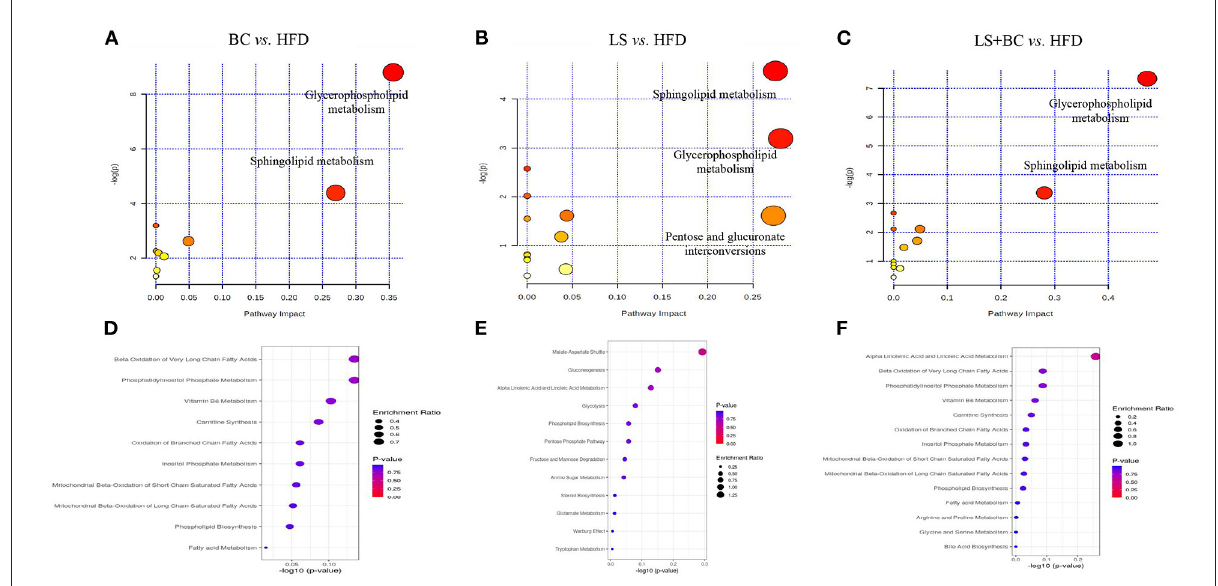
FIGURE7 Lipid metabolic pathway analysis based on significantly differential lipid species in serum. (A–C) All matched pathways are plotted according to p -value from pathway enrichment analysis and pathway impact score from pathway topology analysis. The color and size of each circle represented the p -value and the pathway impact factor, respectively. (D–F) Over Representation Analysis (ORA) is performed and implemented using the hypergeometric test to evaluate whether a particular metabolite set is represented more than expected by chance within the lipid metabolite. One-tailed p -values are provided after adjusting for multiple testing. Enrichment ratio is computed by hits / expected. The color and size of each circle represented the p -value and the enrichment ratio,